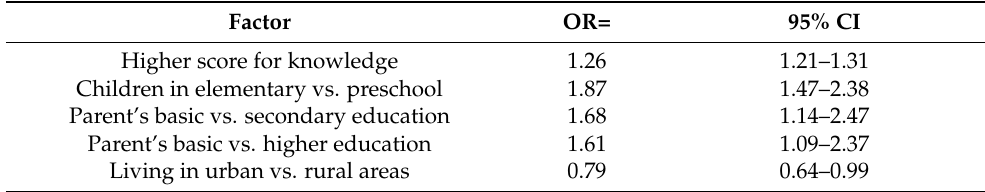
Table 2. Factors influencing the occurrence of pediculosis in children (results of univariate logistic regression